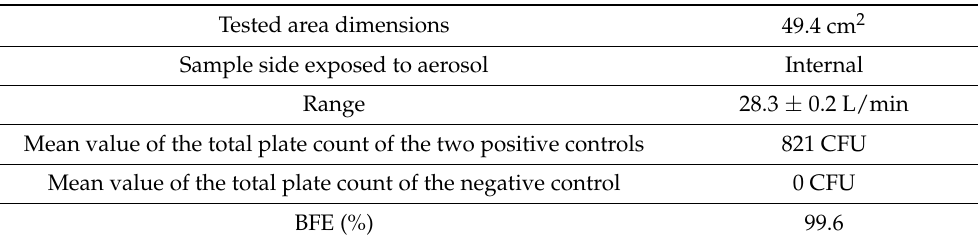
Table 3. Individual BFE values of FFP2 B. All samples exceeded the breathability and bacterial filtration tests (BFE). A BFE value greater than or equal to 98% was found on all samples, as required by the UNI EN 14683: 2019 + AC: 2019 standard.